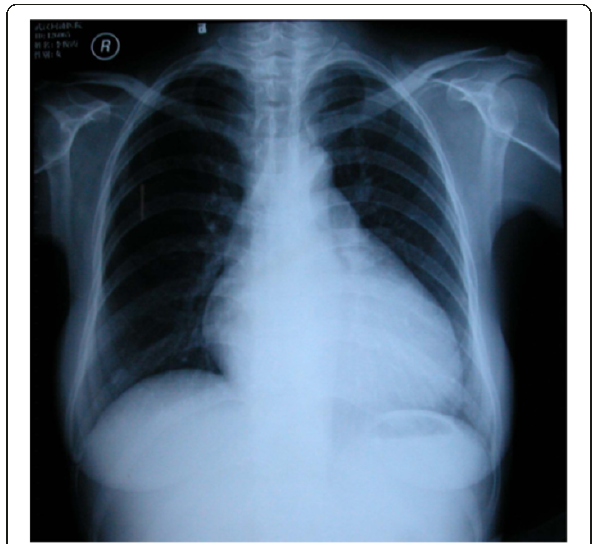
Figure 1 The chest X-ray showed mild increase of transverse cardiac diameter. The left cardiac border protruded left